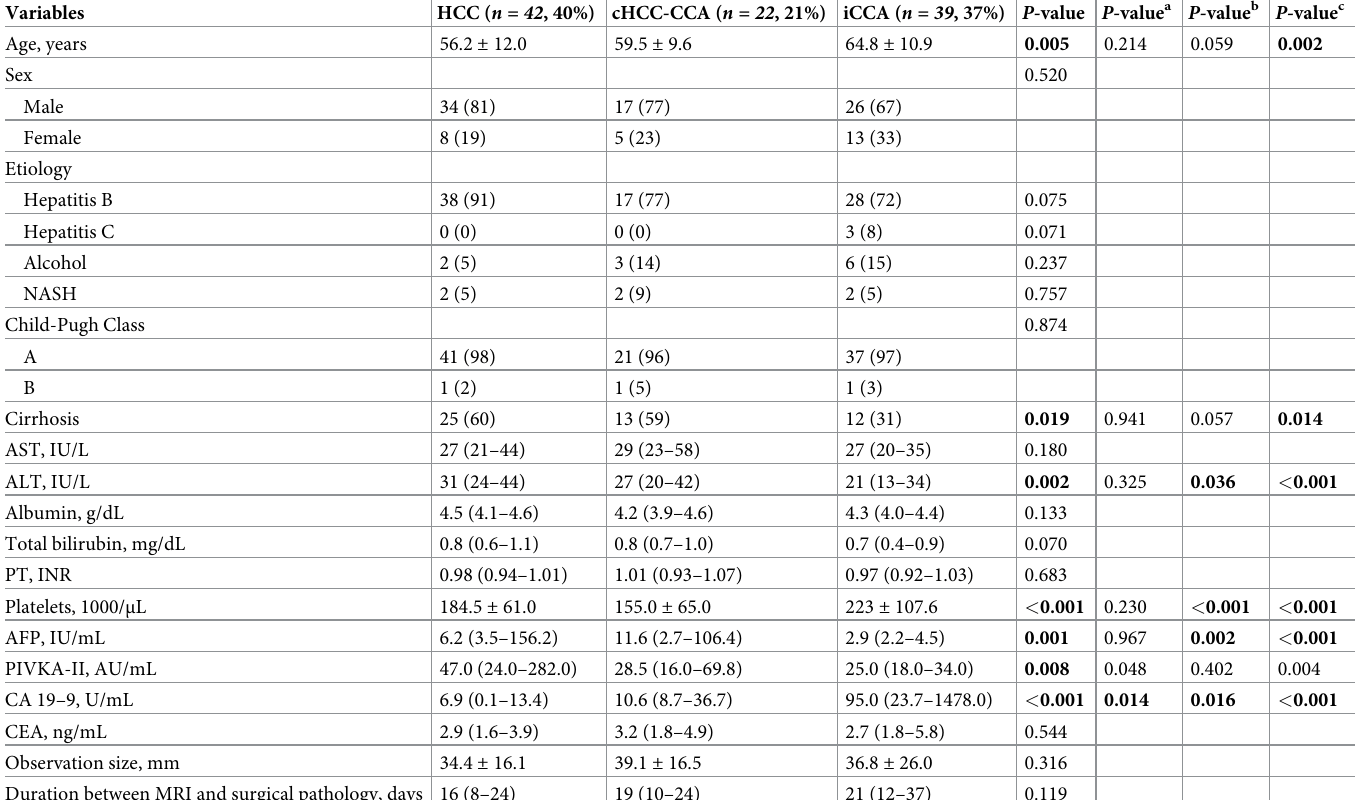
Table 2. Comparison of baseline characteristics of HCC, cHCC-CCA and